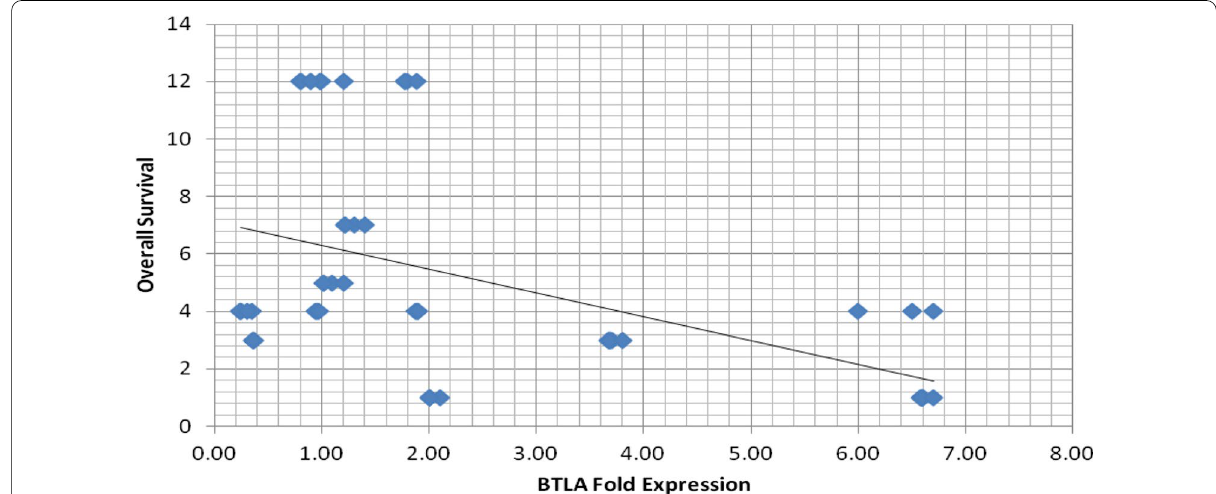
Fig. 4 Correlation of BTLA fold expression with overall survival in AML patients ( n r Spearman’s =